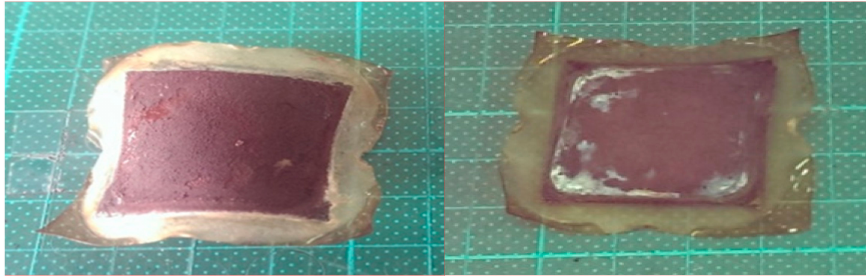
Figure 7. Anode structure after experiments ( a ) for ML and ( b ) for